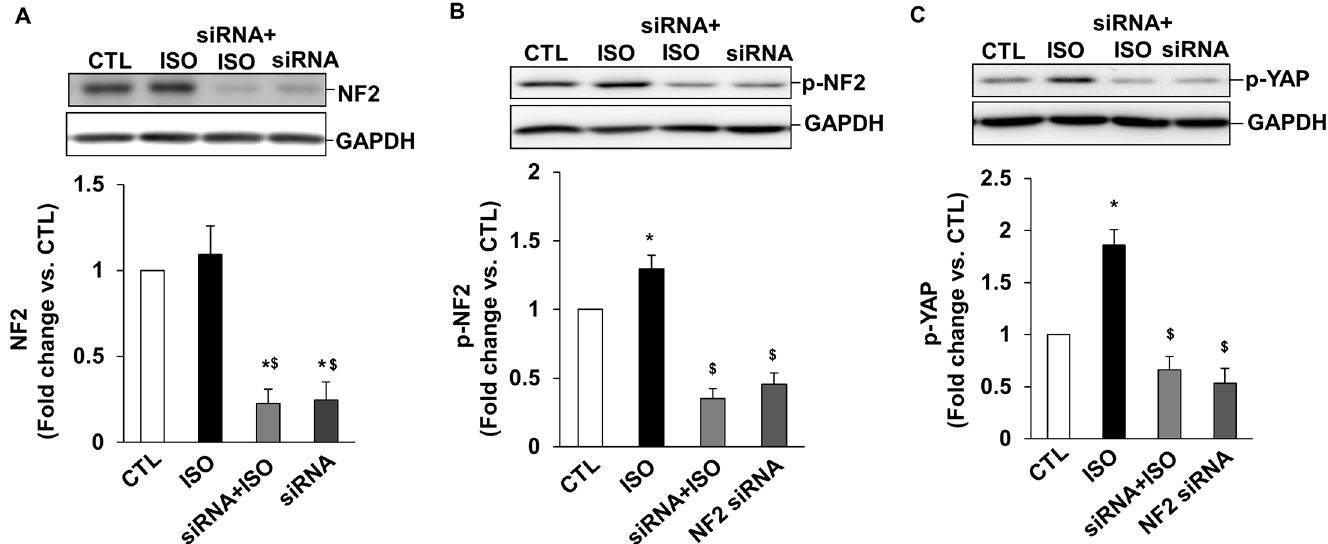
Fig 7. Knockdown of NF2 using siRNA decreases β -AR-stimulated increase in NF2 and YAP phosphorylation. H9C2 cells were transfected with NF2 siRNA for 48 h followed by treatment with ISO for 15 min. Cell lysates were analyzed by western blot using anti-NF2 (A), phospho-specific anti-NF2 (B) and phospho-specific anti-YAP (C) antibodies. The lower panels exhibit the mean data normalized to GAPDH, (cid:3) P < 0.05 vs.CTL; $ p < 0.05 vs. ISO; n = 3.